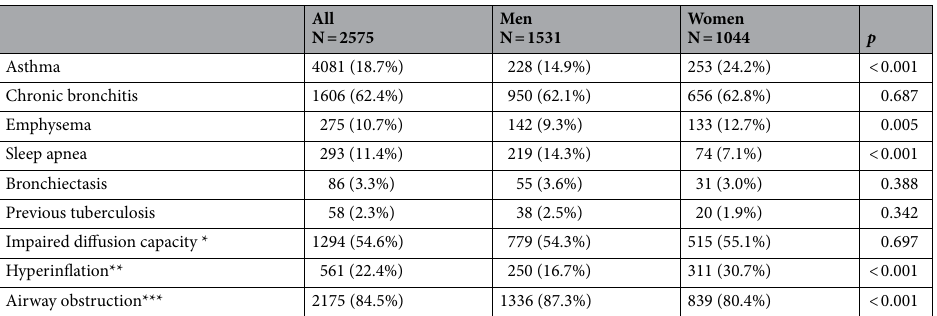
Table 3. Pulmonary comorbidities, the “pulmorbidome”. Absolute numbers and percentages are given. p values refer to the comparison between women and men and were derived from Chi-square statistics. For 69 patients no TLC values were available, for 207 FRC/TLC values were missing. Impaired impaired diffusion capacity * was defined by DLCO ≤ 60, hyperinflation** by FRC/TLC ≥ 130%predicted and Airway obstruction*** by FEV 1 /FVC <